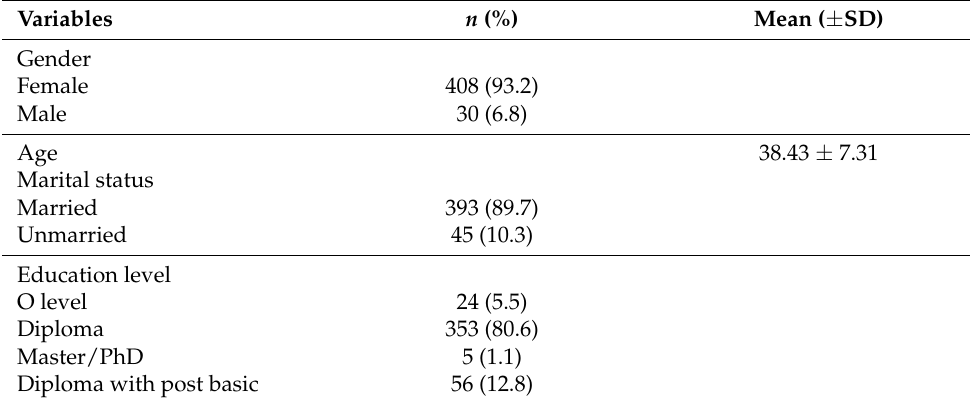
Table 1. Socio-demographics of the participants ( n = 438).